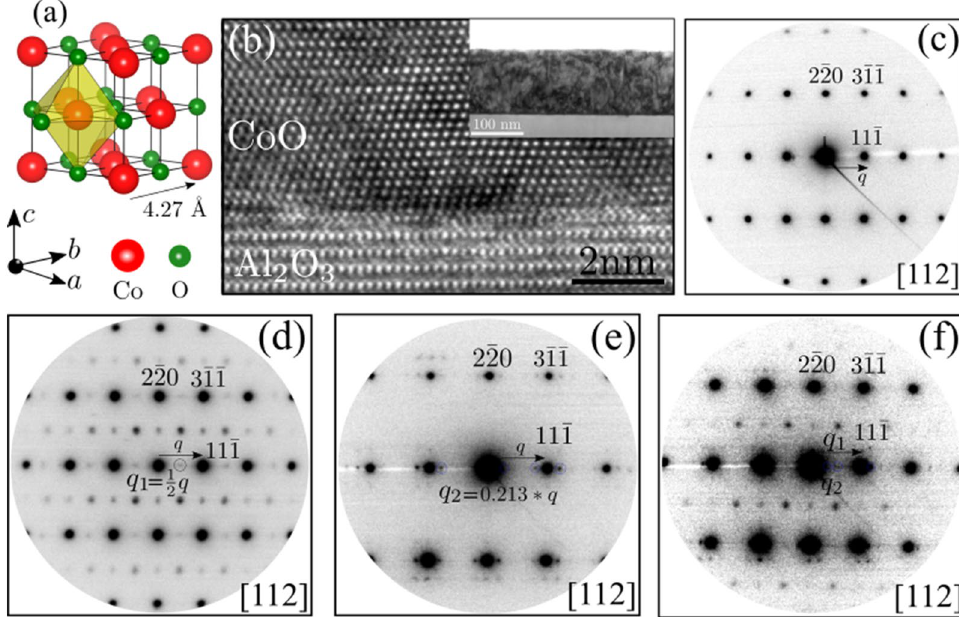
Figure 1. Probing the periodic lattice deformation in the reciprocal space. ( a ) Rock-salt type crystal structure of CoO. ( b ) HR-TEM image of CoO showing the interface with the sapphire substrate. The inset image shows a large-scale bright-field image of the CoO thin film. ( c ) EDP showing the crystalline nature of the CoO thin film. ( d , e ) EDPs showing the presence of a COM and an ICOM CO phase in the CoO lattice. ( f ) EDP showing the coexisting COM and ICOM CO phases in the CoO